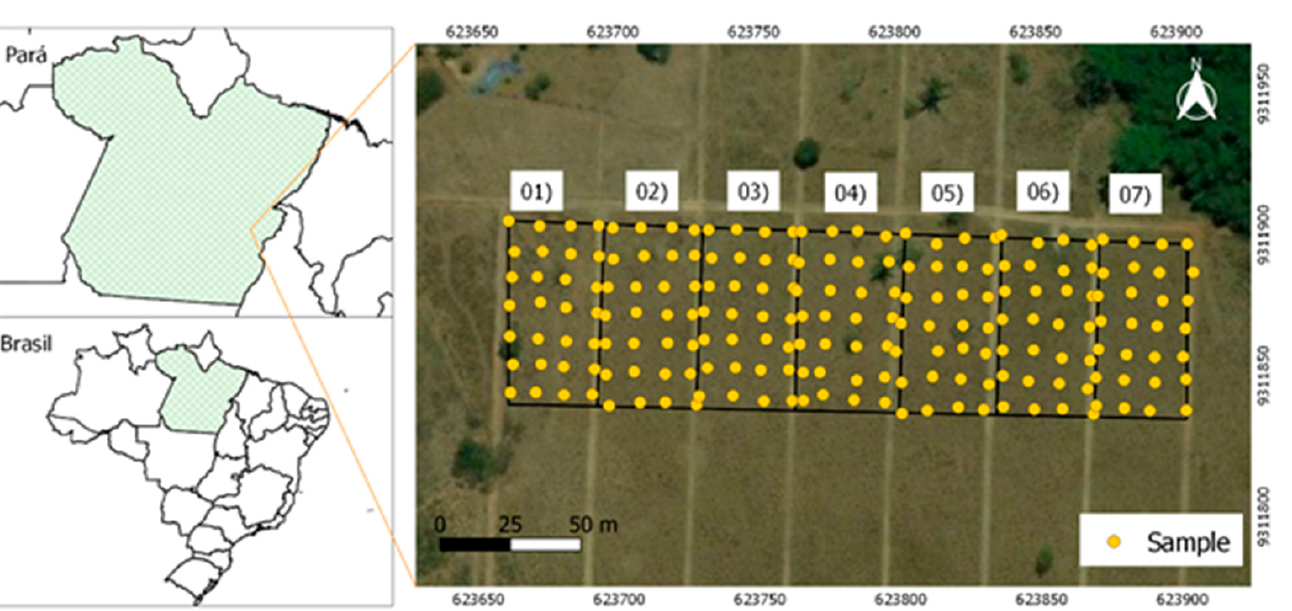
Table 1. Soil granulometric analysis at depths of 0.0–0.2 and 0.2–0.4